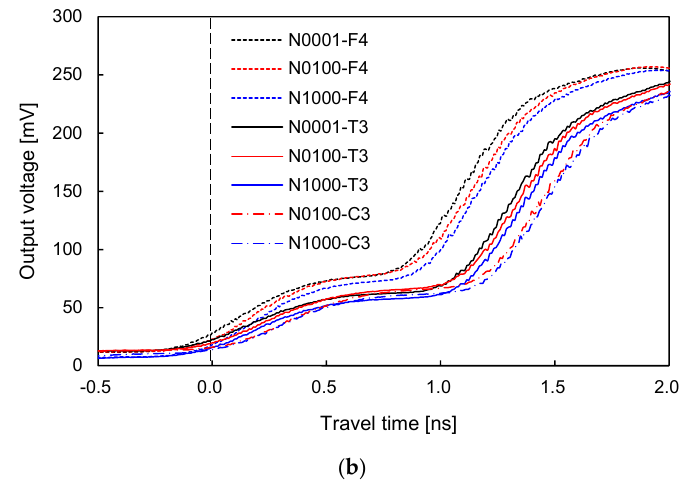
Figure 7. Typical signals of TDR of sand–silt mixtures subjected to N = 1, 100, and 1000: ( a ) SF = 0%; ( b ) SF = 100%. Nn denotes the number of repetitive loading.